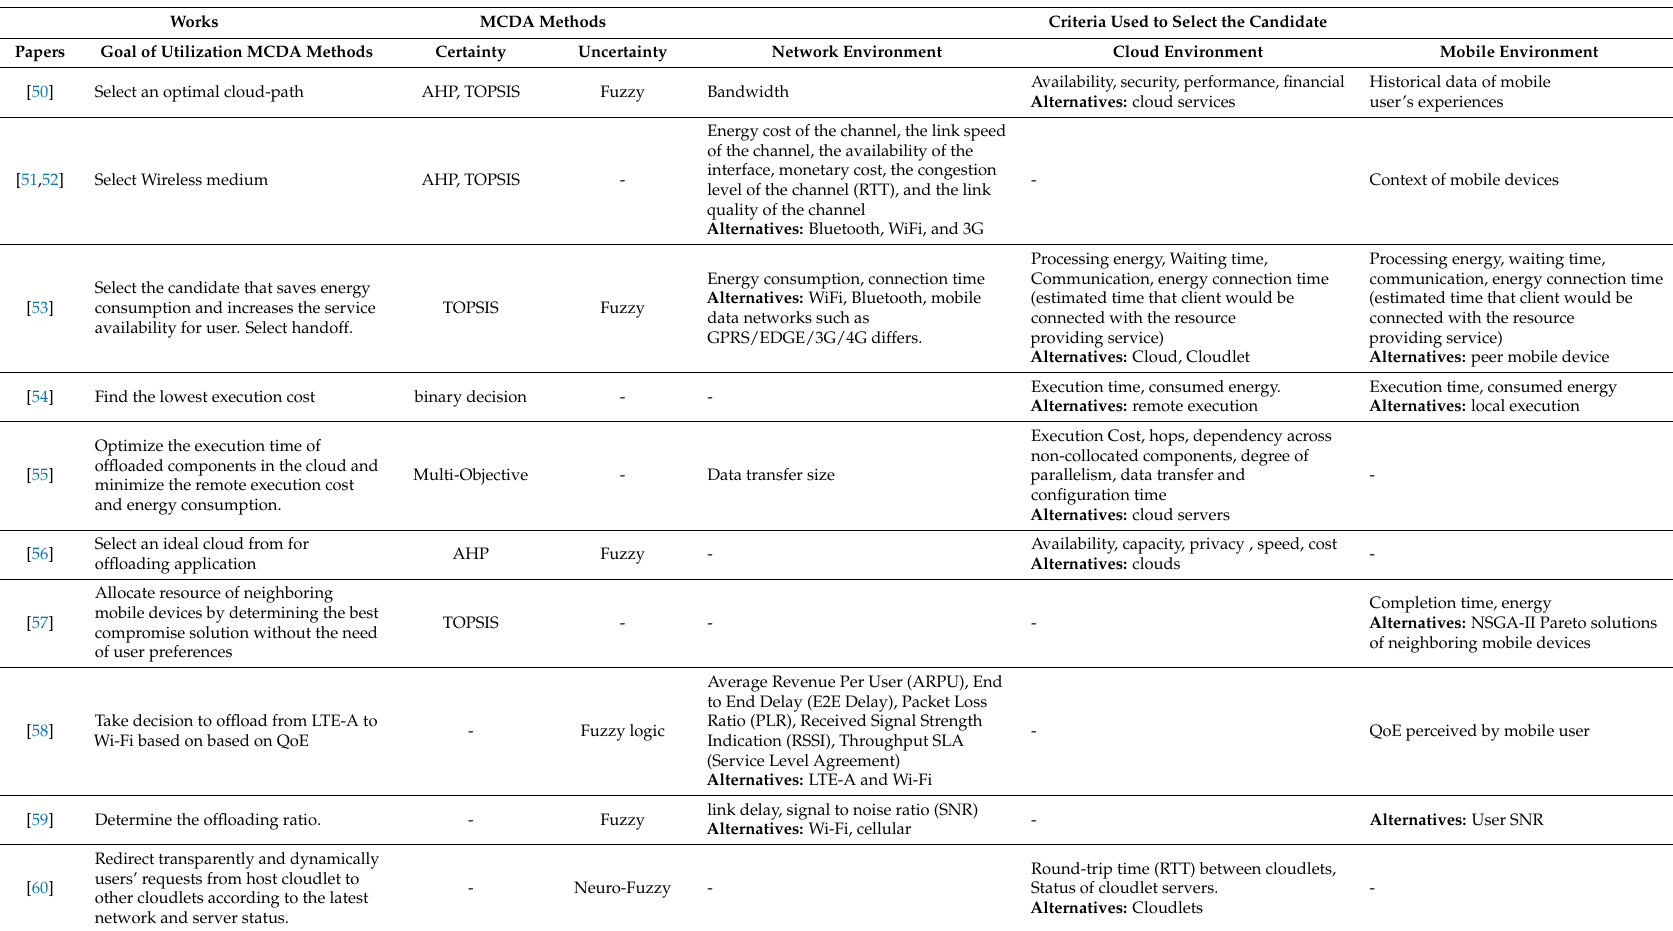
Table 3. Offloading process based on MCDA